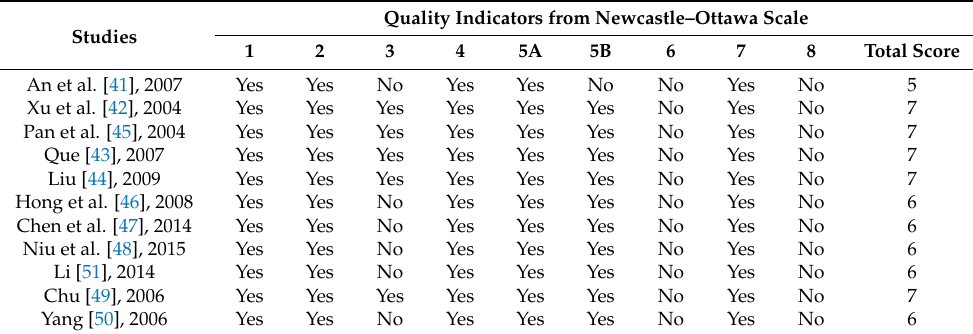
Table 2. Assessment of Study Quality.